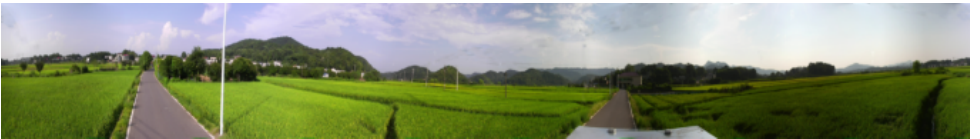
Figure 25. Camera orientation causes sinusoidal distortion in the image. For a sloping path, the two sides of the picture are uplifted, whereas the middle part sinks to the right.